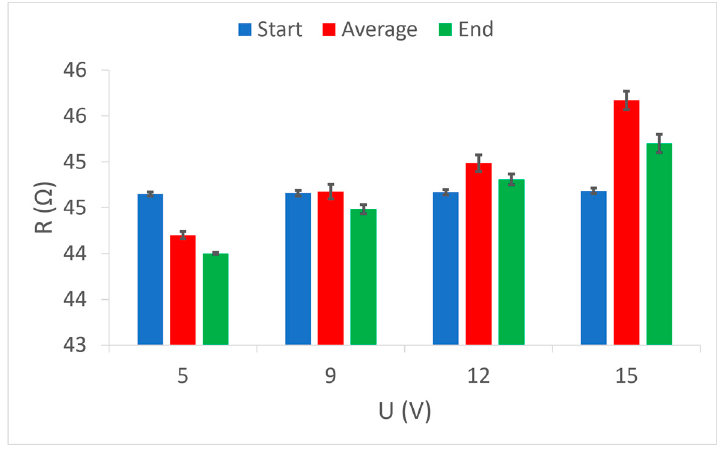
Figure 11. Comparison of three resistance values (start, average, and end) at given voltage values in sample 3.